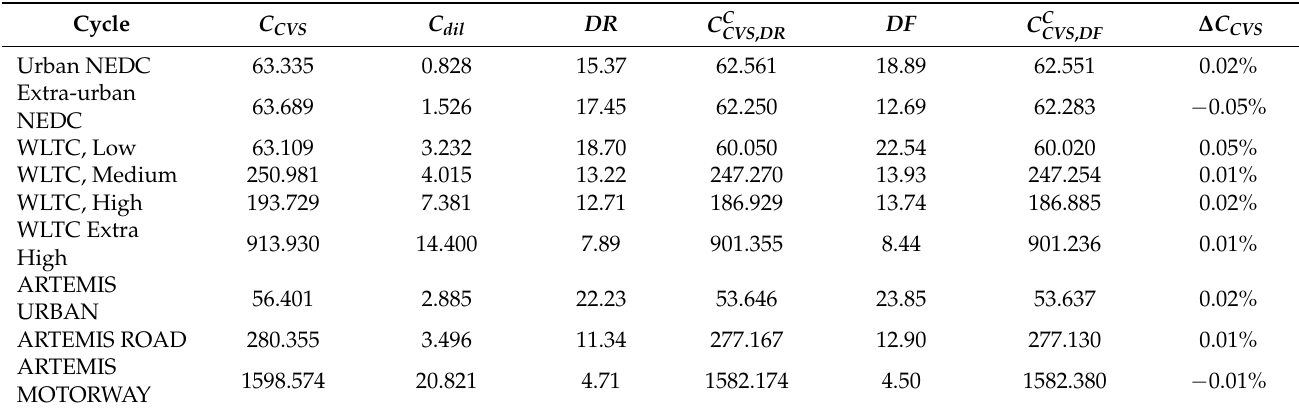
Table A7. The C CVS,corr calculated based on Equations (5) and (21) for Euro 6 NEDC vehicle with SI engine, CO concentration [ppm].